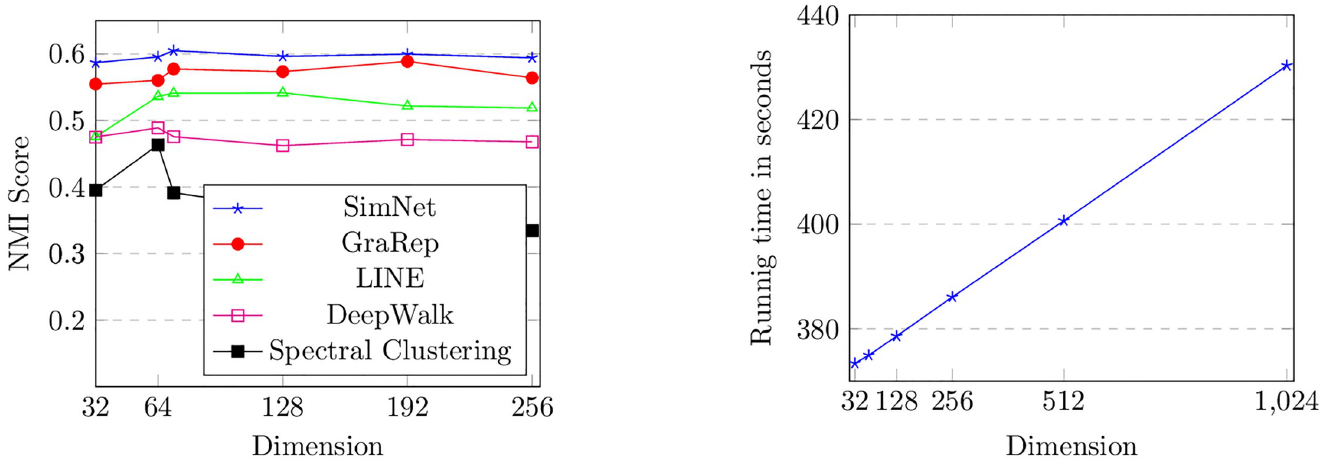
Fig 5. Left: Performance of different methods over different dimensions for 9NG network. Right: Running time.